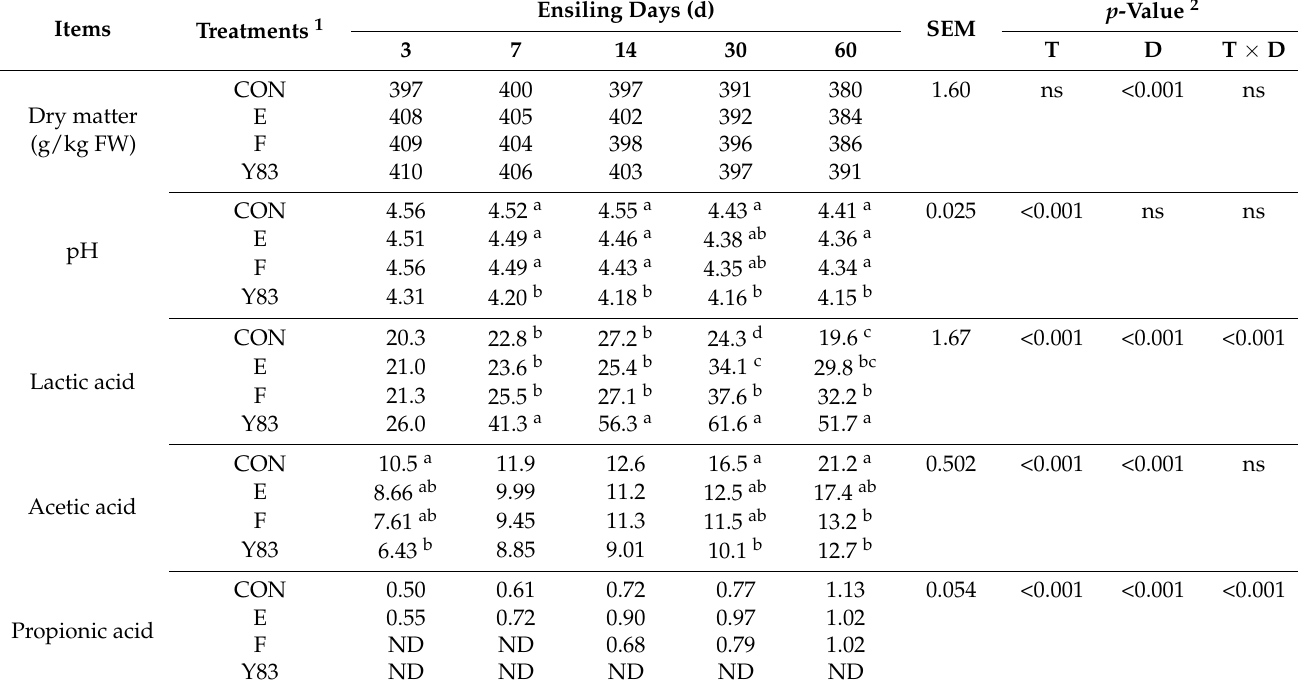
Table 2. Effect of additives on fermentation quality of rice straw silage (g/kg DM or as